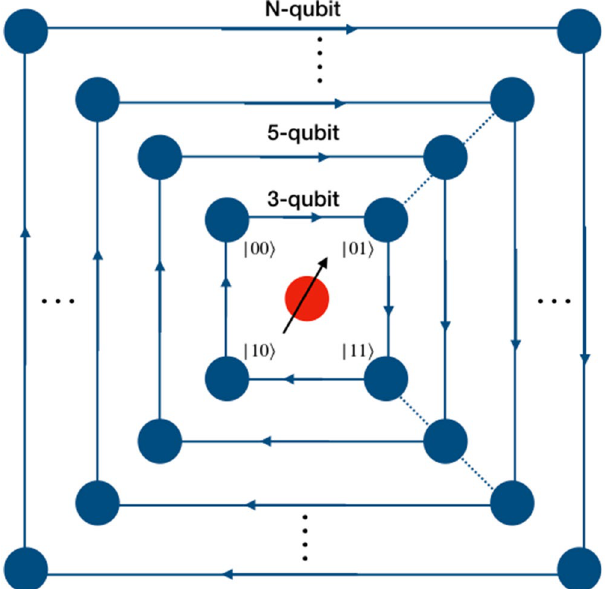
Figure 12. An illustration of scaling of three-qubit equivalent system to N-qubit system. Multiple closed graphs of four vertices equivalent to two qubit can be used to extended the quantum walk based universal quantum computer physically. Red solid circle is represents